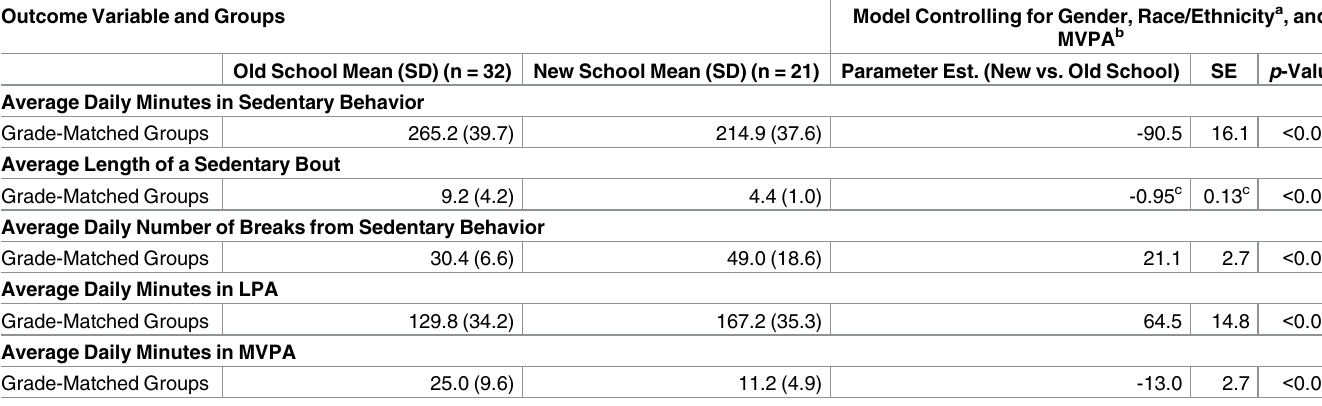
Table 3. Grade-matched independent samples differences in sedentary behavior and physical activity. Outcome Variable and Groups Model Controlling for Gender, Race/Ethnicity a , and